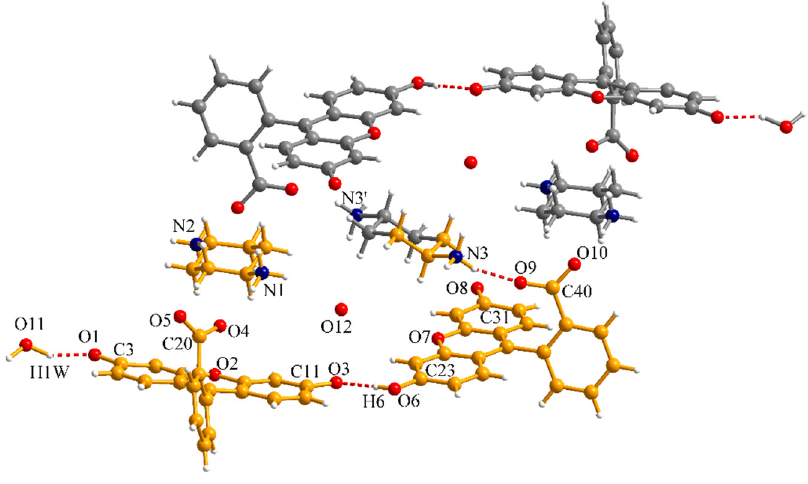
Figure 18. Crystal structure of compound 10 . The asymmetric unit is depicted in orange. Symmetry